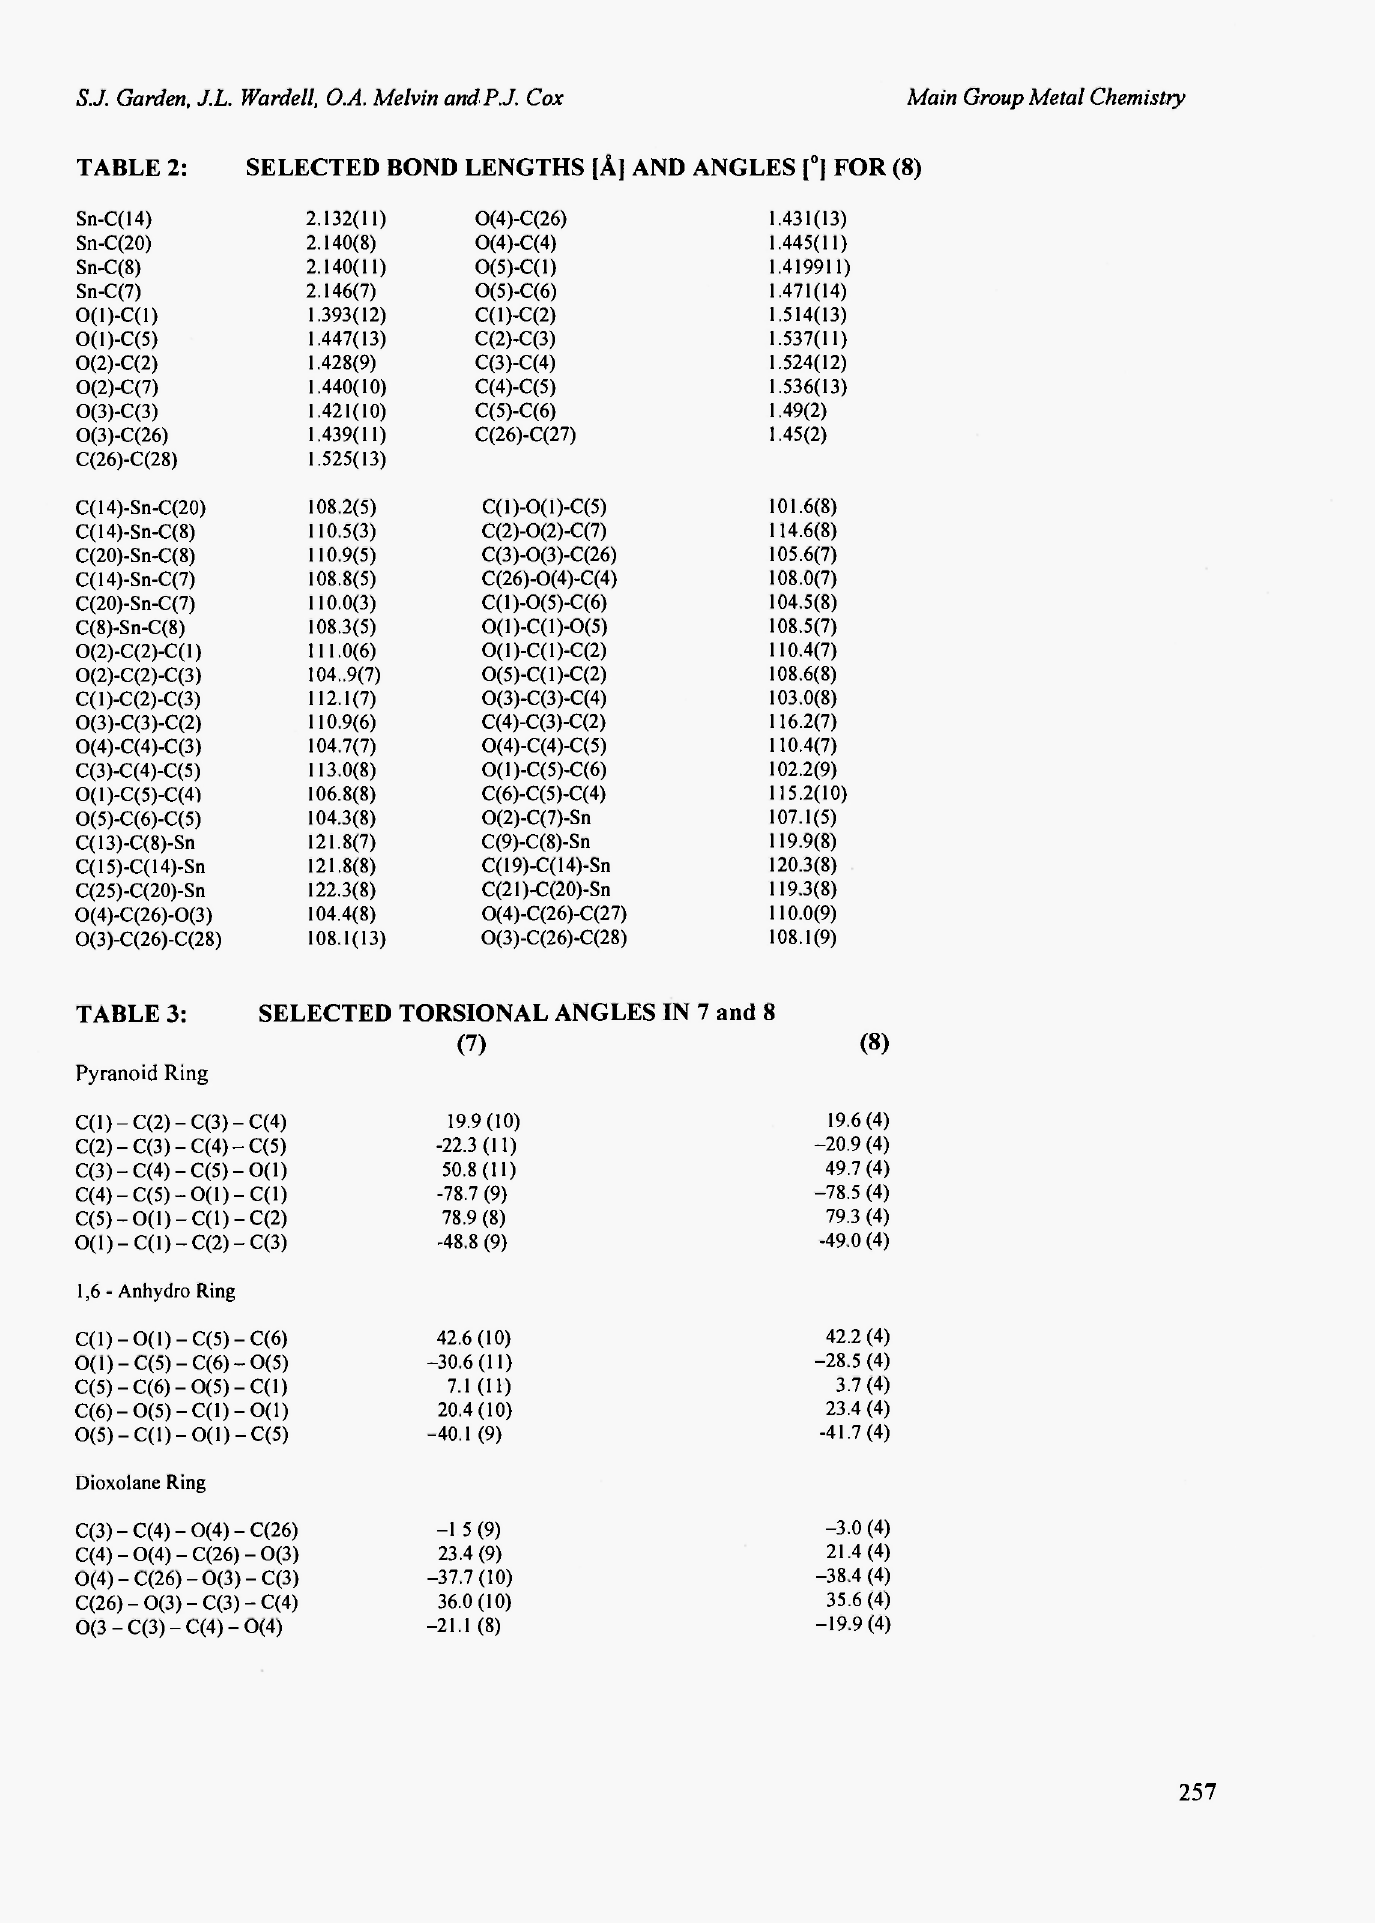
SELECTED TORSIONAL ANGLES IN 7 and 8 Pyranoid